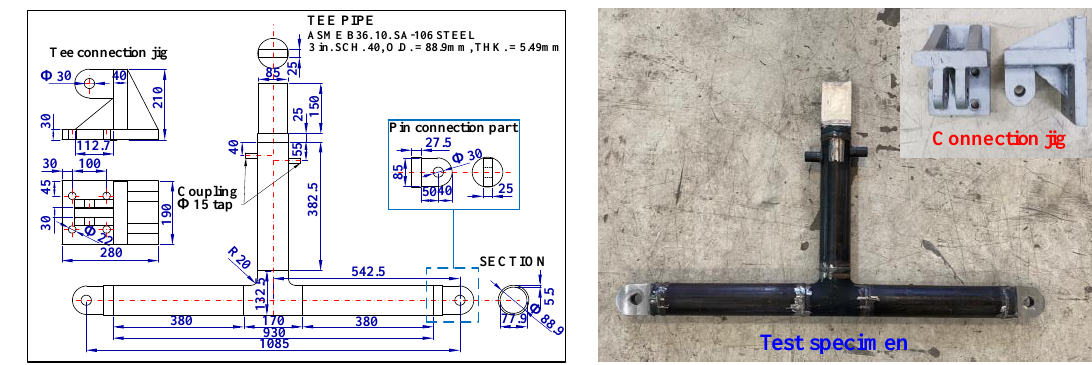
Figure 1. Test specimen and connection jig.